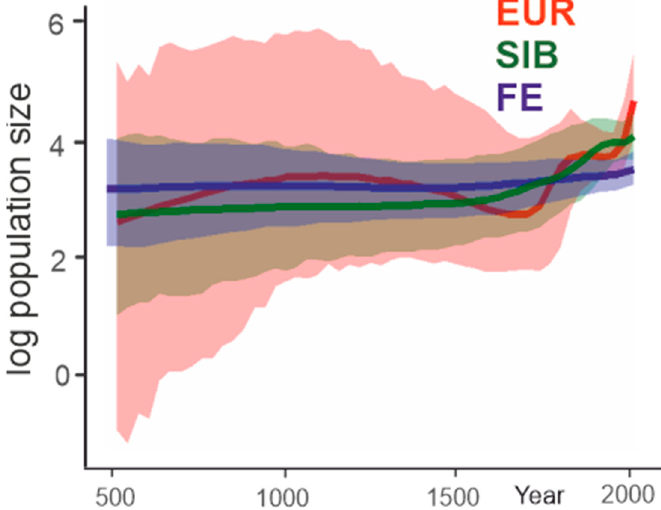
Figure 9. Past population dynamics inferred for the three major TBEV subtypes using the Bayesian Skygrid model.